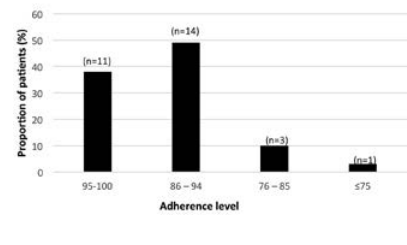
Figure 2. Self-assessment of adherence to treatment by answering a convenience questionnaire.